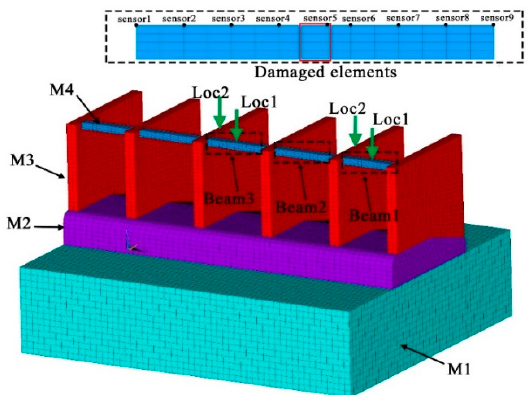
Figure 6. Finite element model of the sluice system. Table 1. Material parameters of the sluice system.